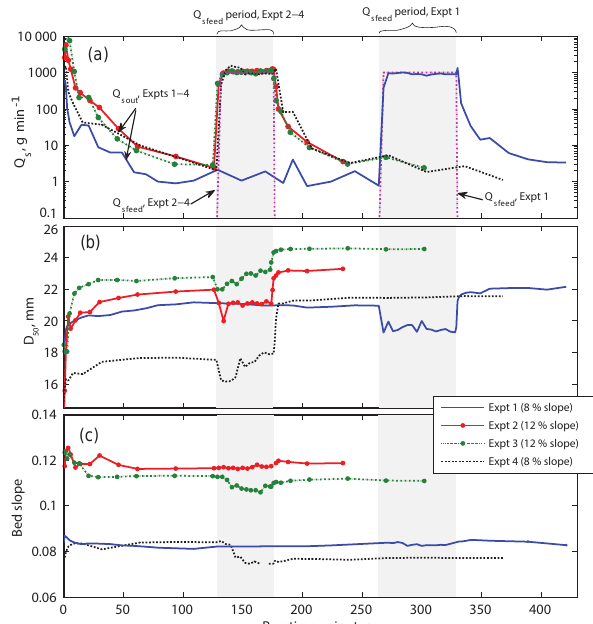
Figure 2. Flume experiment data (Johnson et al., 2015). (a) Sedi- ment transport rate in ( Q sfeed ) and out of the flume. The upstream sediment supply rate was zero other than during the Q sfeed period. Experiment 1 was run for a longer duration than the others but shows similar trends. Note that the outlet Q s adjusts much faster to match the increase in supply than it does to decrease during peri- ods of no input. (b) Median bed surface grain diameters decreased during the feed of finer gravel, and then increase beyond their pre- vious stable bed. (c) Flume-averaged bed slopes changed relatively little even as transport rates and D 50 changed greatly in response to initial bed stabilizing and supply